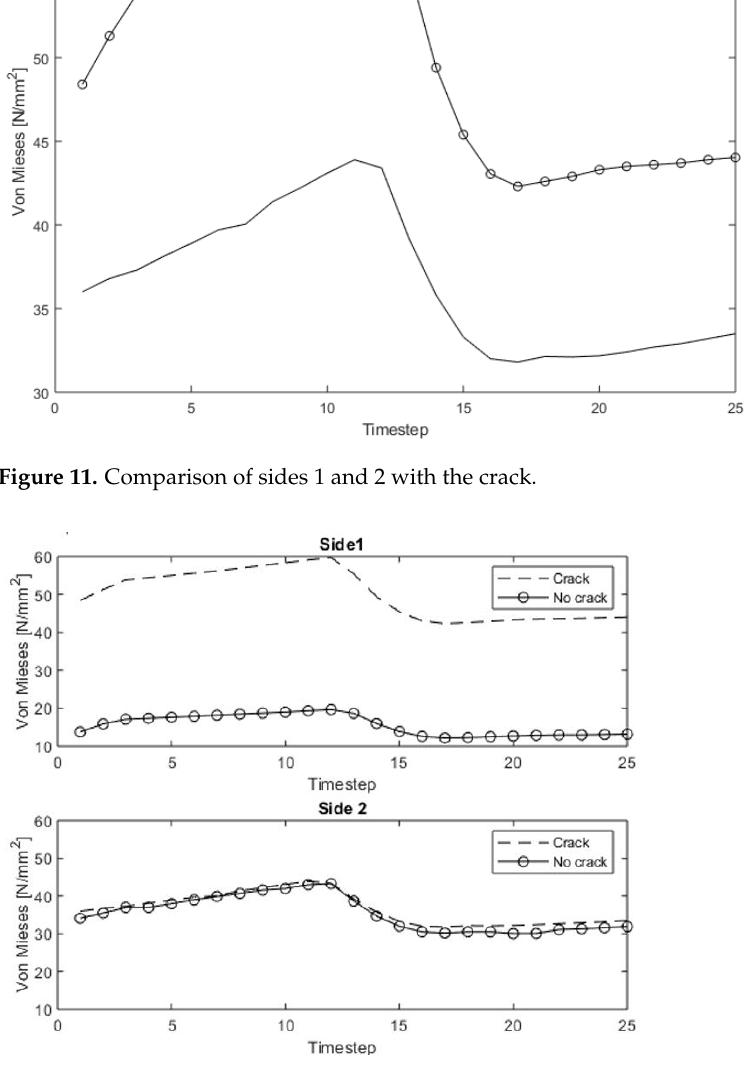
Figure 11. Comparison of sides 1 and 2 with the crack.